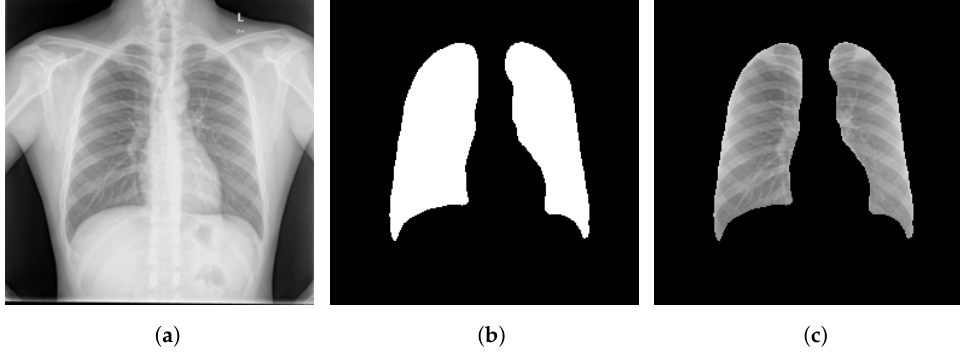
Figure 2. Original image, a segmentation mask, and image with mask applied for CHNCXR_0024_0 in 166 CR partition: ( a ) Original image; ( b ) segmentation produced by DeepLabv3+ with ResNet50; ( c ) mask in ( b ) applied to ( a